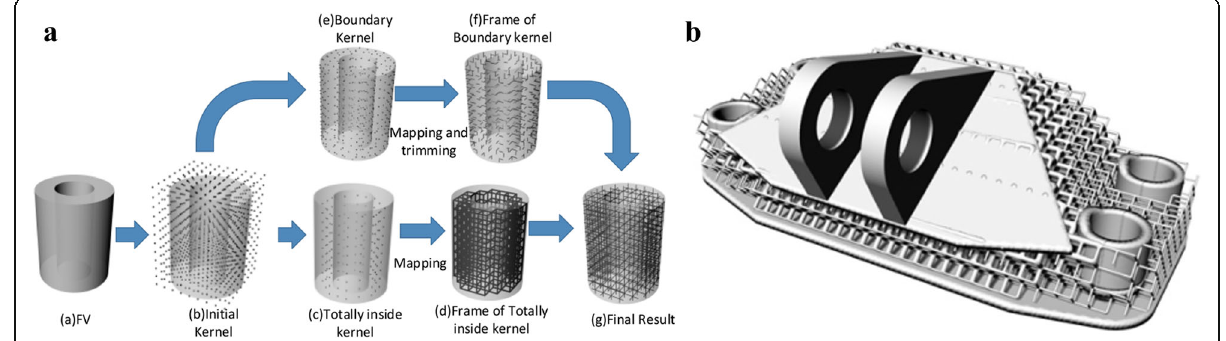
Fig. 21 BESO-based lattice design method: a The whole design process. b Optimized lattice result